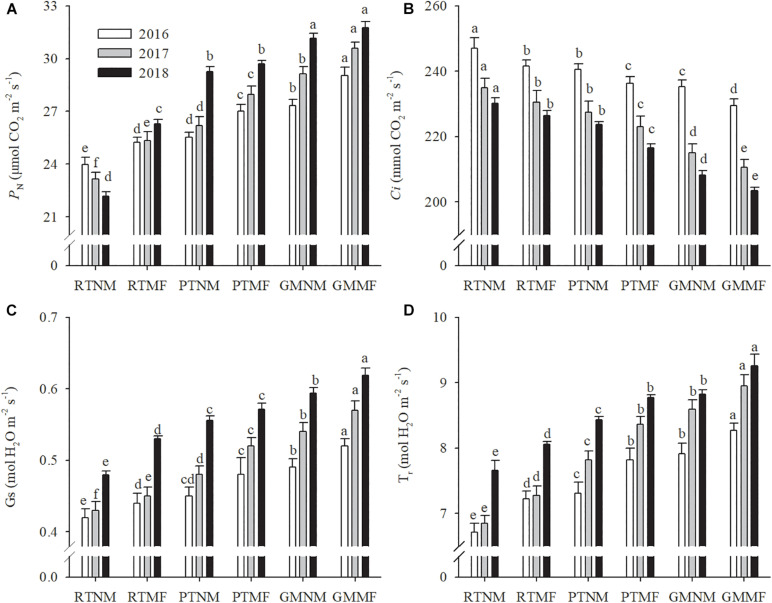
Effects of soil tillage managements and mulching film on leaf photosynthesis rate (A), intercellular carbon dioxide concentration (B), transpiration rate (C), and stomatal conductance (D). Vertical bars represent standard error (SE). Mean values ± SE (n = 10). Different letters indicate significant differences among each treatment, P < 0.05.